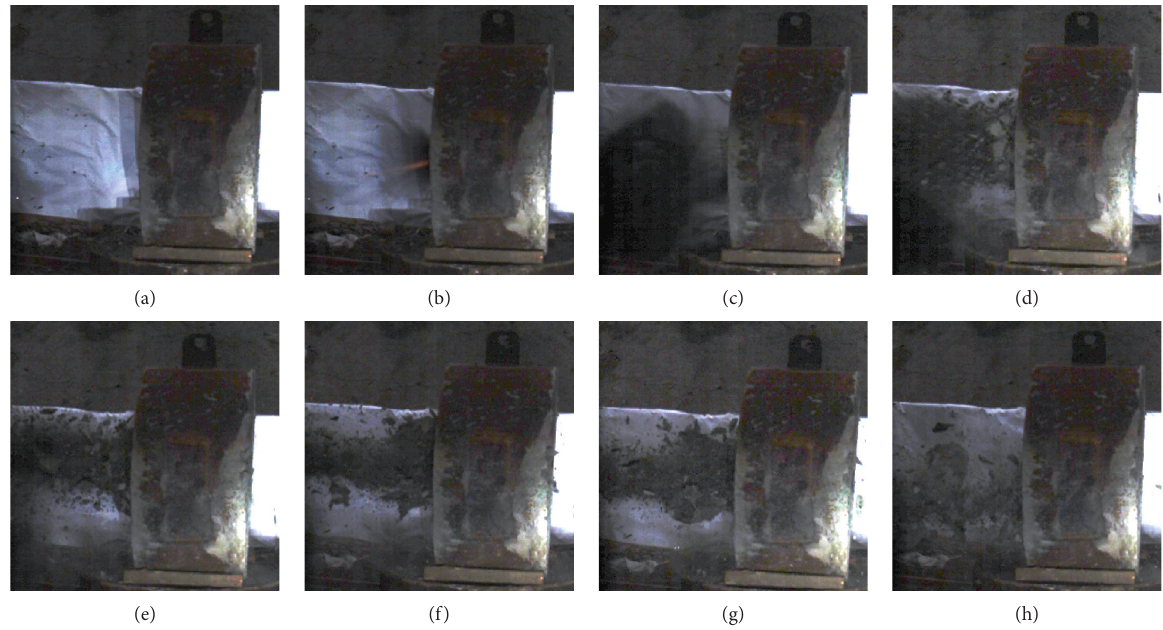
Figure 9: No. 7 explosion experiment and concrete throwing image. (a) t � 0s, (b) t � 0.001s, (c) t � 0.0025s, (d) t � 0.01 s, (e) t � 0.03s, (f) t � 0.075s, (g) t � 0.09s, and (h) t � 0.18s.